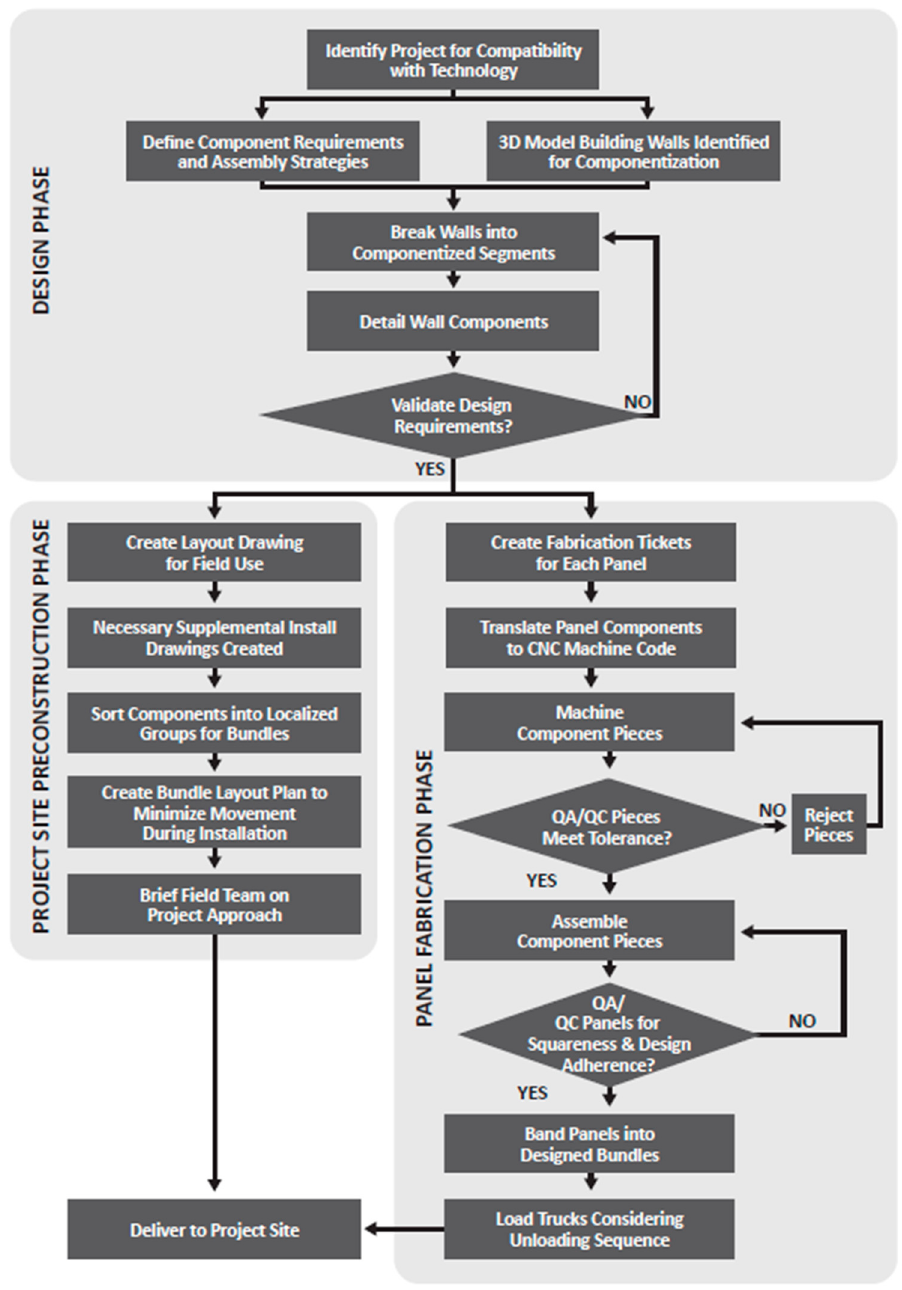
Figure 1. Productivity model.